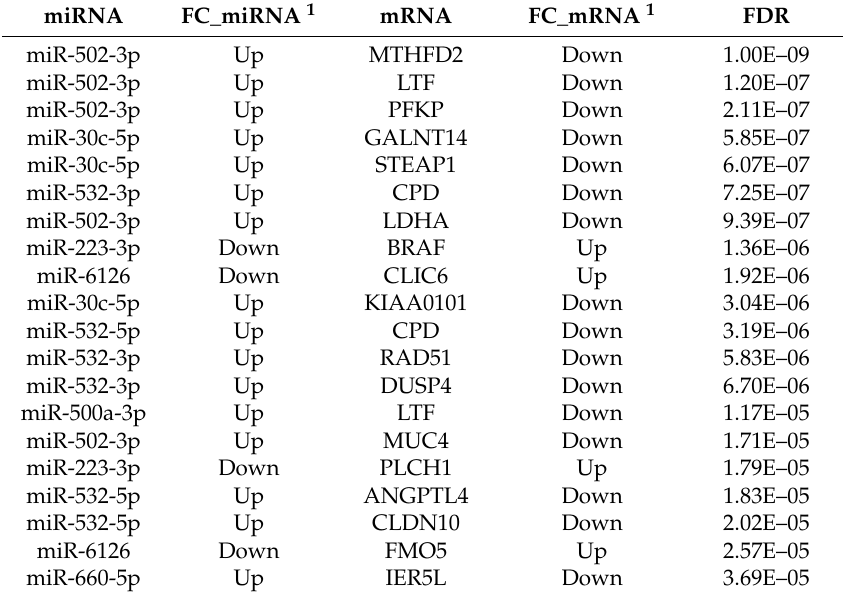
Table 6. Top 20 significant miRNA–mRNA interaction